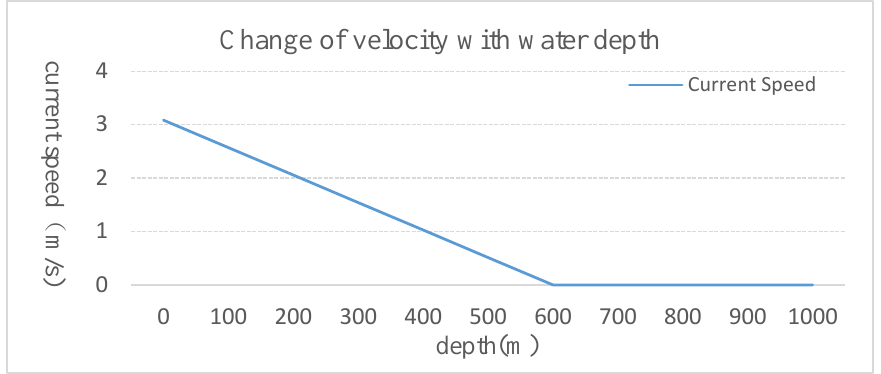
Figure 11. The relationship between velocity and water depth.